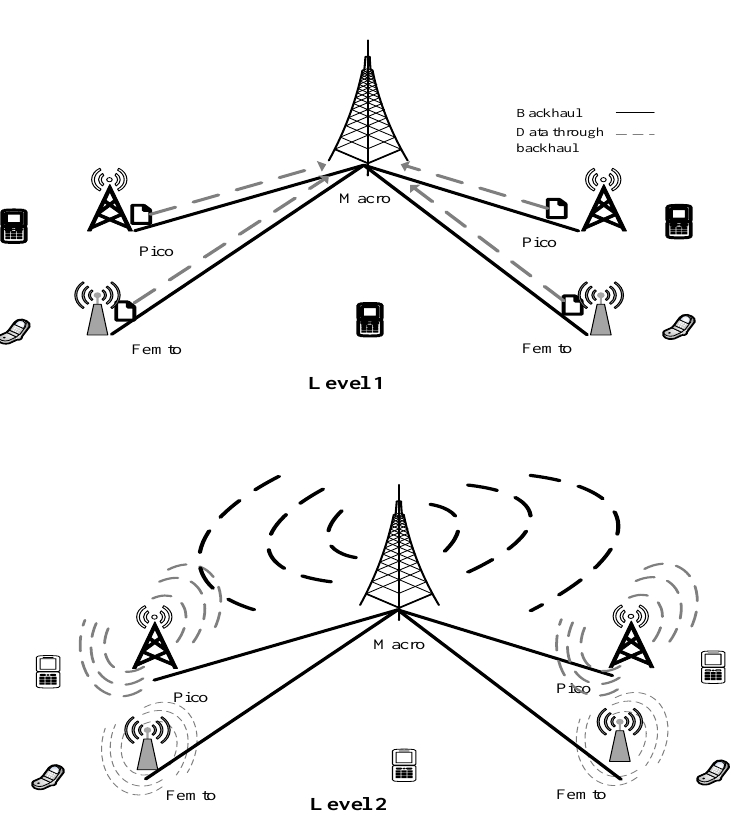
Figure 3. Two-level load transmission. In Level One, all the small-cell BSs, pico and femto, send their respective load value to macro BS. In Level Two, all the base stations (BSs) broadcast their load